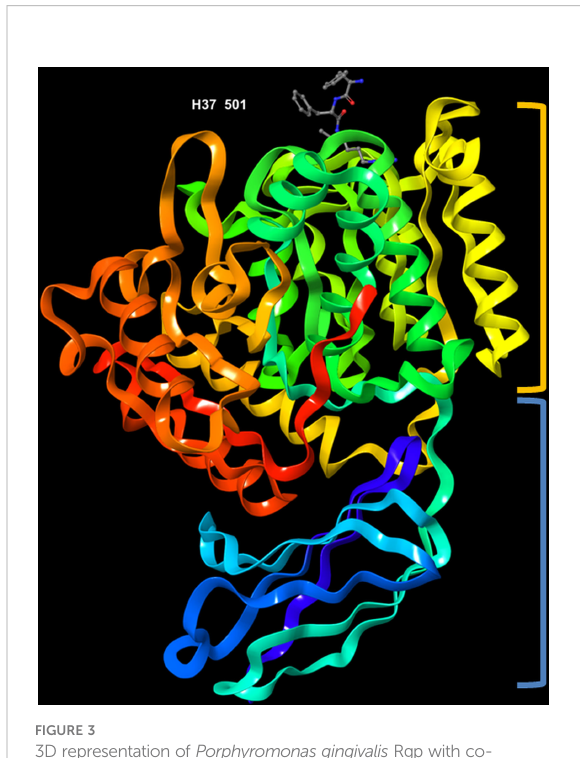
FIGURE 3 3D representation of Porphyromonas gingivalis Rgp with co- crystallized ligand, D-Phe-Phe-Arg-chloromethylketone, labelled H37 501 (PDB ID: 1CVR). Highlighted in orange: crown (catalytic domain), blue: root (IgSF